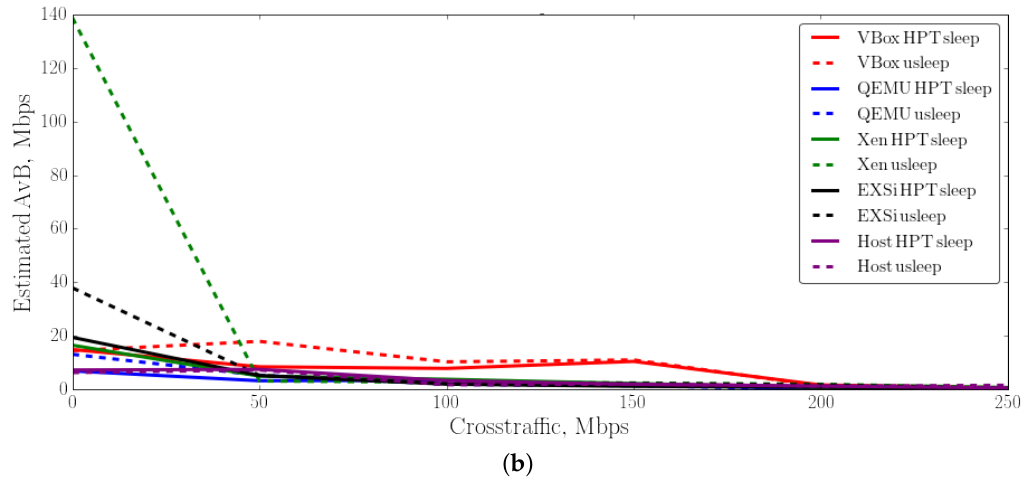
Figure 16. AvB estimation results by Yaz in Virtual Environment: ( a ) medians; and ( b )